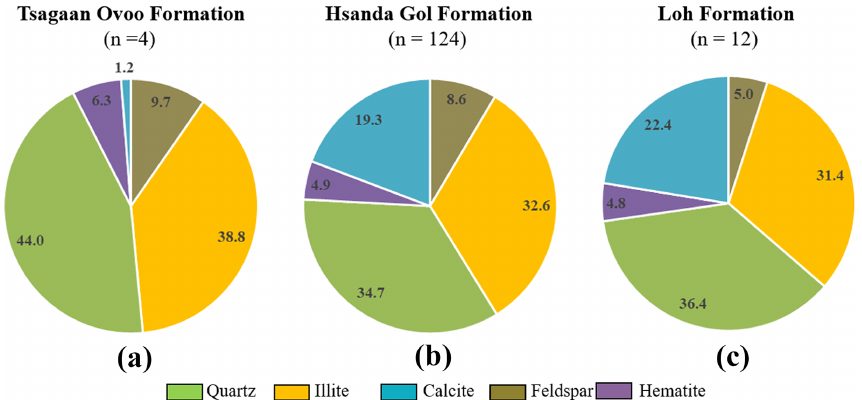
Figure 3. Averaged mineralogical composition (in wt%) of the sediments from the (a) upper-Eocene Tsagaan Ovoo Formation, (b) Oligocene Hsanda Gol Formation and (c) lower-Miocene Loh Formation from the Valley of Lakes, determined by XRD analysis. Table 1. Compilation of illite polytype quantification and K–Ar ages of grain size subfractions of sediments collected from the TAT section ( ∼ 90 . 5m), TGR-C section ( ∼ 78 . 0m), SHG-D section ( ∼ 55 . 5m) and TGR-AB section ( ∼ 35 . 0m). The analytical error for the K–Ar age calculations is given as a 95% confidence level (2 σ ). STP denotes standard temperature and pressure, and cps refers to count per